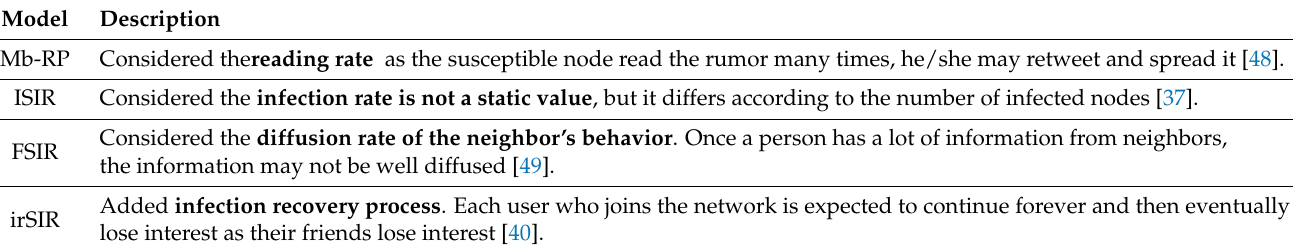
Table 2. Different Modifications to the Classical SIR Model by Considering New